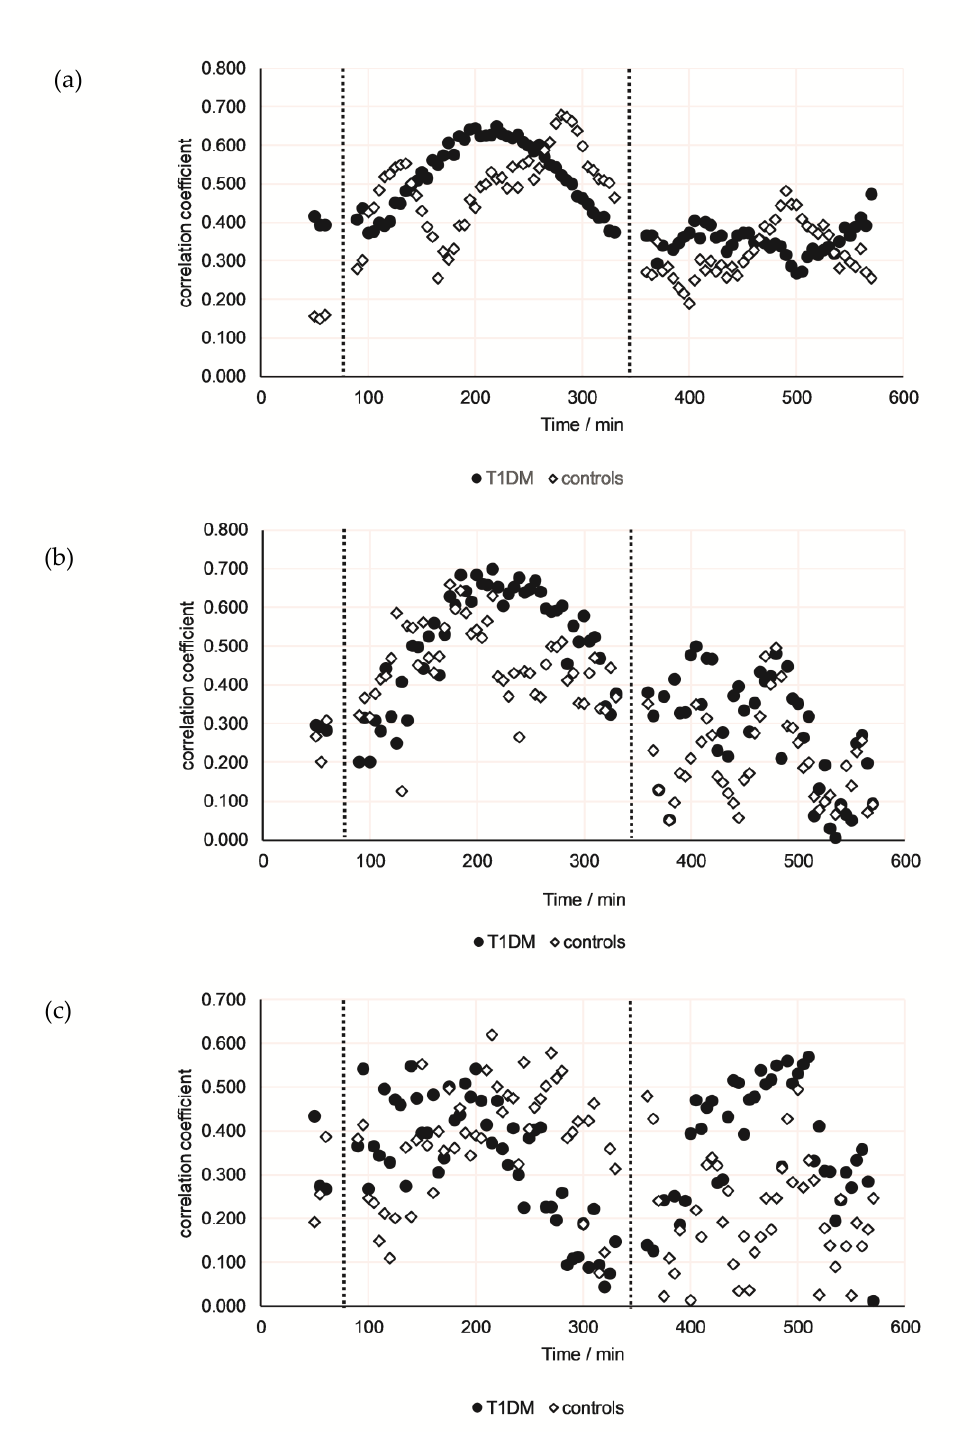
Figure 5. Time resolved correlations between acetone and interstitial glucose concentration (correlation coe ffi cient versus time, 95 correlations in total). Dotted lines indicate intake of standardized meals. Full dots: T1DM patients ( n = 21), empty squares: Healthy controls ( n = 22); ( a ) acetone; ( b ) 2-propanol; and ( c )